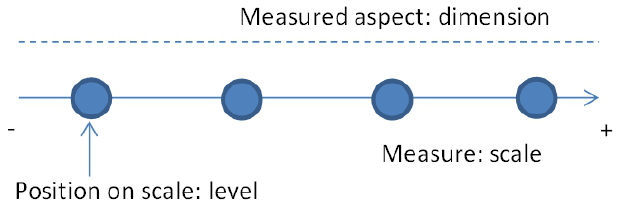
Fig. 1 . Dimensions, scales, and levels as outlined in this